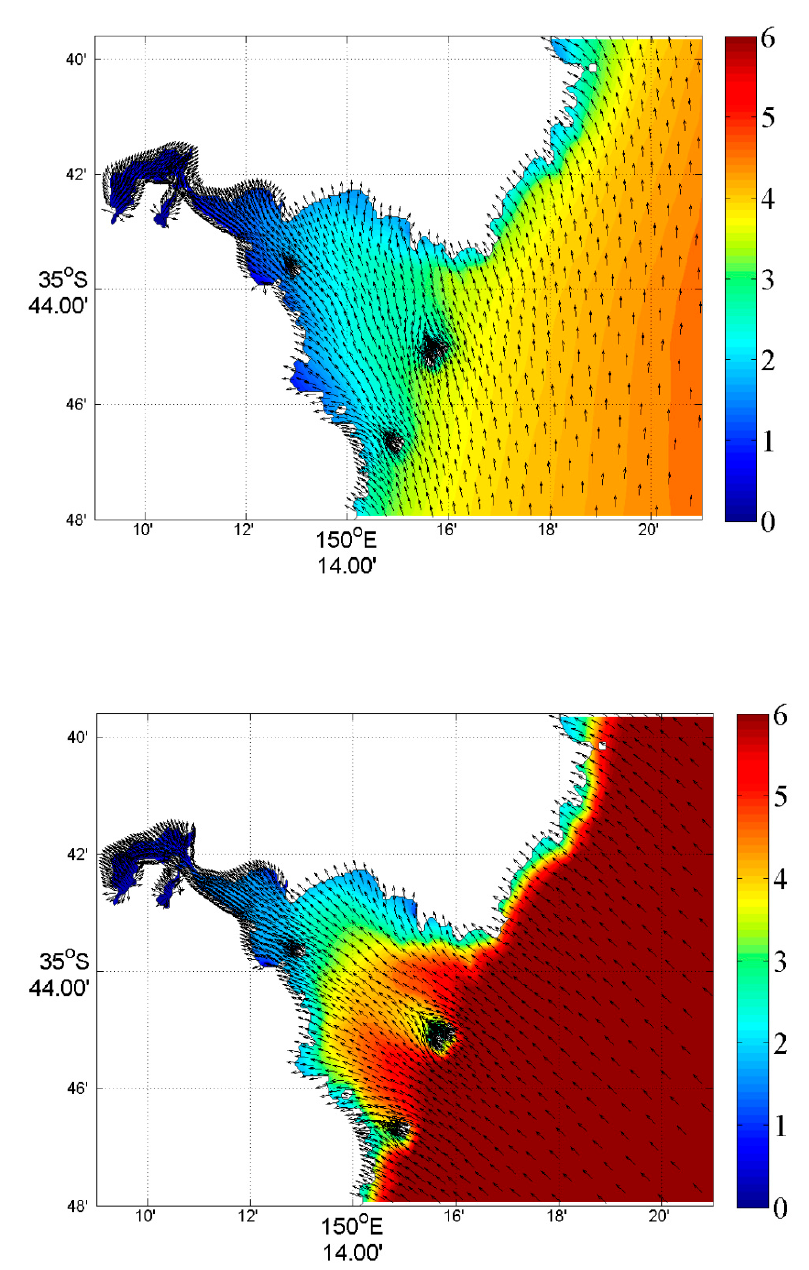
Figure 6. Model predicted a significant wave height and direction for prevailing south-westerly winter winds ( top ) and prevailing south-easterly summer winds ( bottom ), with a constant storm wind speed of 25.7 m/s. The wave direction is indicated by vectors.